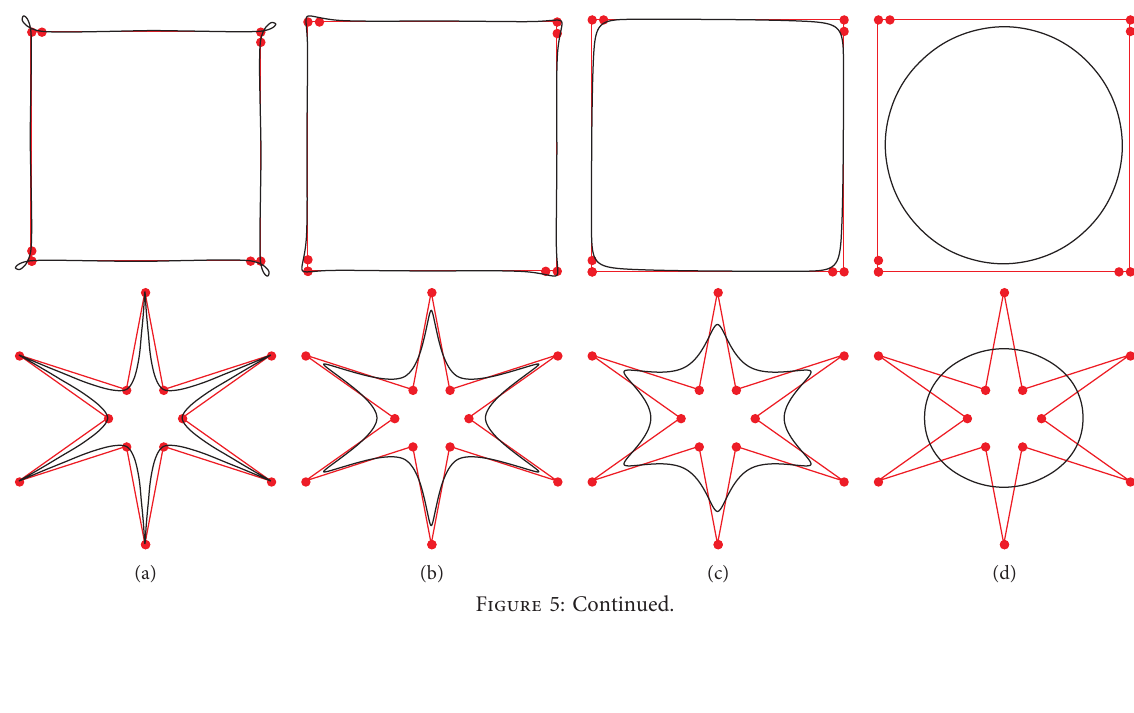
Figure 4: Black curves are the limit curves obtained by the subdivision schemes: (a) S , (i) S a I 8